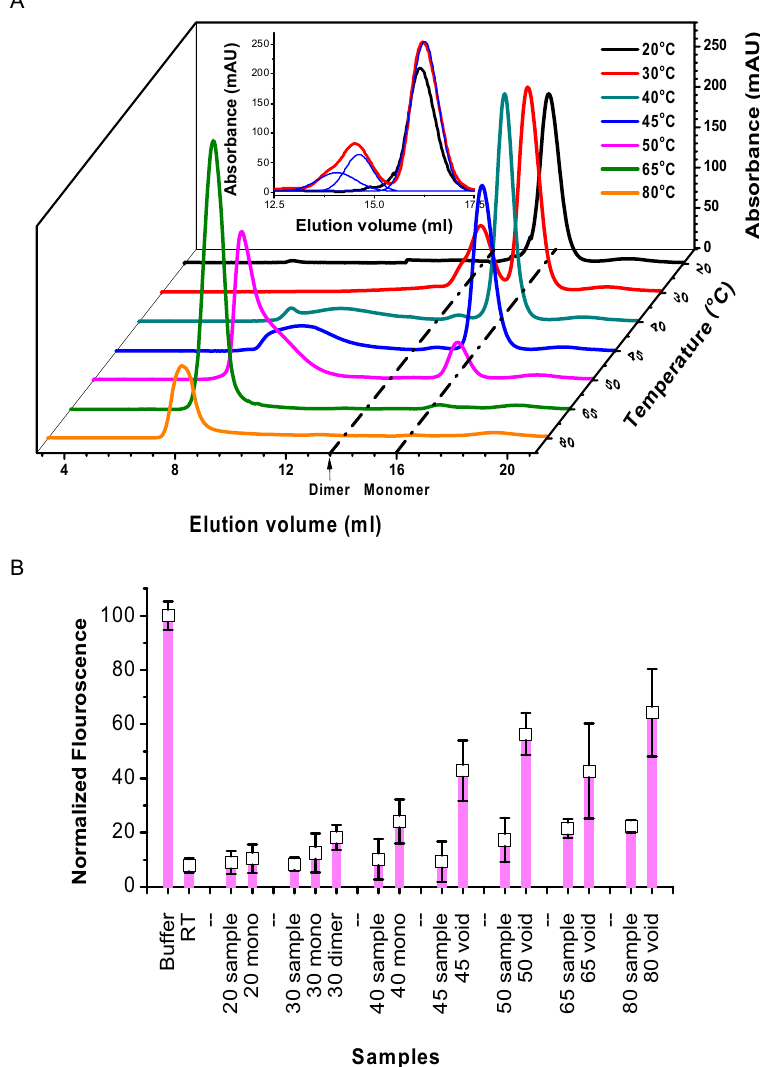
Figure 6. ( A ) SEC elution profiles of the samples heated at different temperature are presented here. Inset shows the comparison of the peaks seen for the samples at 20 and 30 °C. The latter shows additional peaks corresponding to mass of dimer of 28–161. ( B ) The F-actin depolymerization activity of the heated samples and different peaks collected from their SEC are shown here. The samples or fractions for which activity are shown have been mentioned